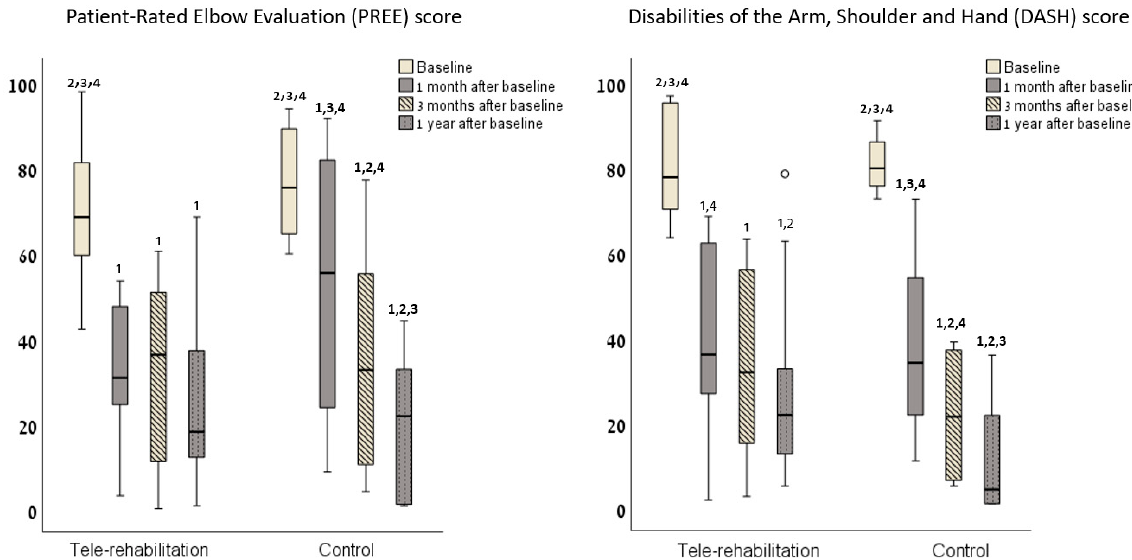
Figure 3. The Patient-Rated Elbow Evaluation (PREE) (left frame) and Disabilities of Arm, Shoulder and Hand (DASH) (right frame) scores for each group at baseline (before the intervention) and at the 3 postintervention timepoints. The numbers above each box plot represent statistical significance between timepoints, as follows: 1 Statistically significant differences with the test performed at baseline. 2 Statistically significant differences with the test performed after 1 month. 3 Statistically significant differences with the test performed after 3 months. 4 Statistically significant differences with the test performed after 1 year.